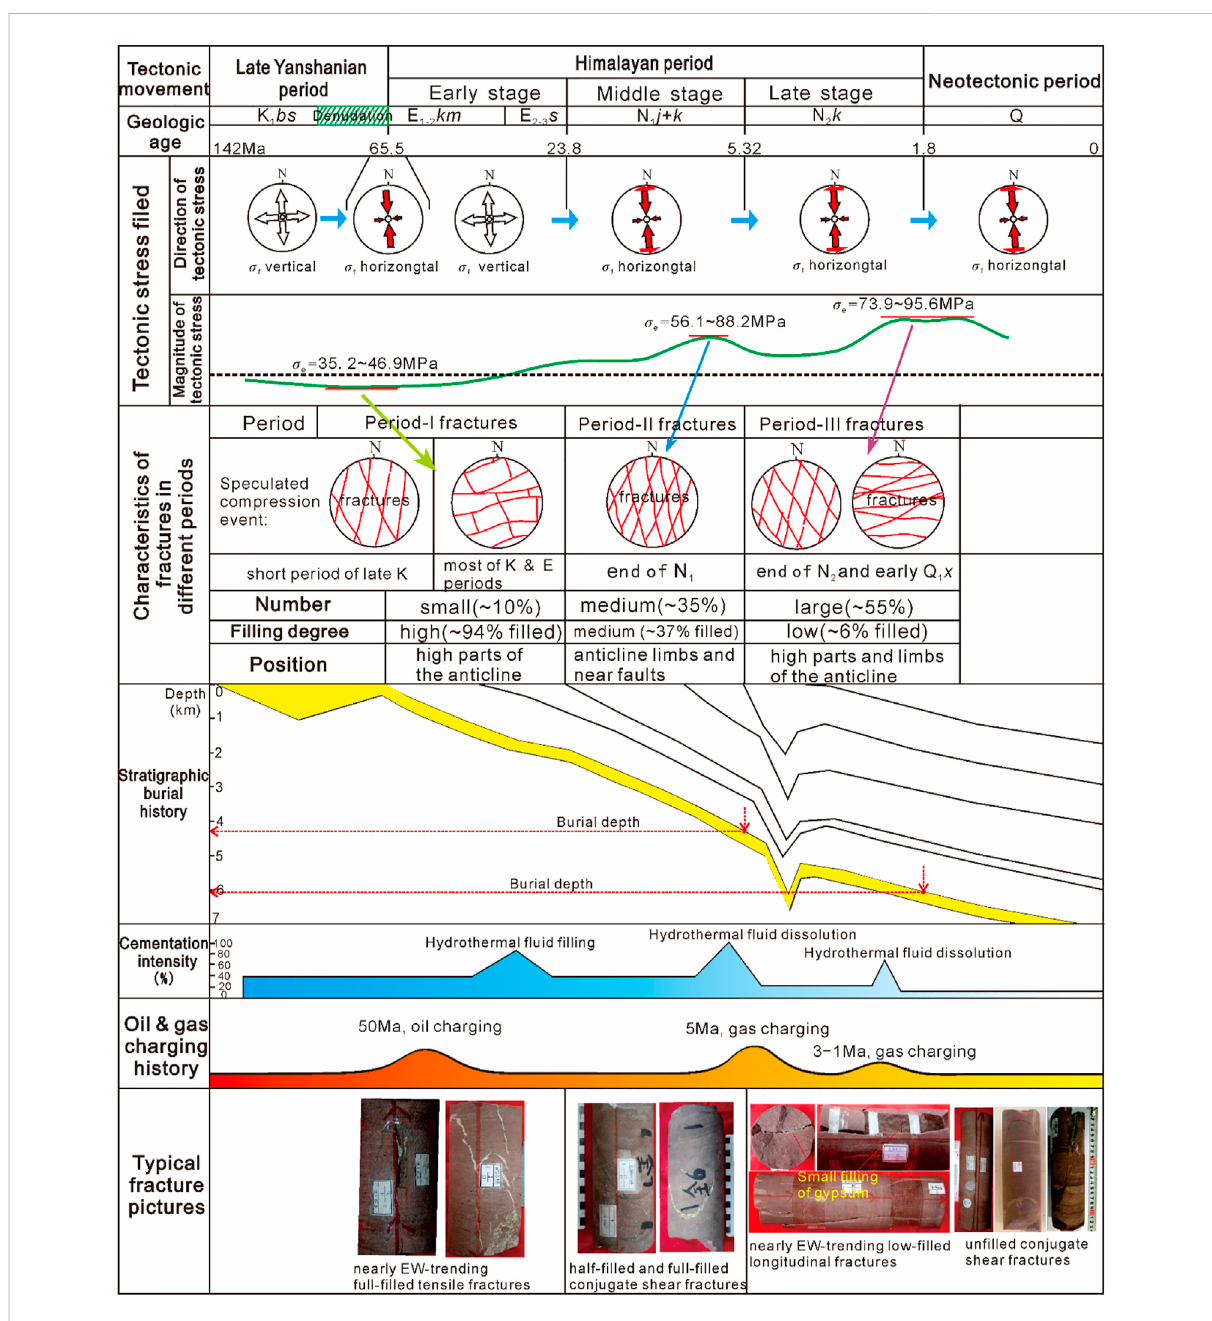
FIGURE 4 Sequence of fracture formation and cementation relativeto regionaltectonic events and burial history and for the Kuqa Depression.Part of the paleostress data from Zeng et al. (2004) and Li et al. (2015). And, the statistics of diagenetic cementation and fracture fi lling are derived from a large number of microscopic thin slices and drilling core data,